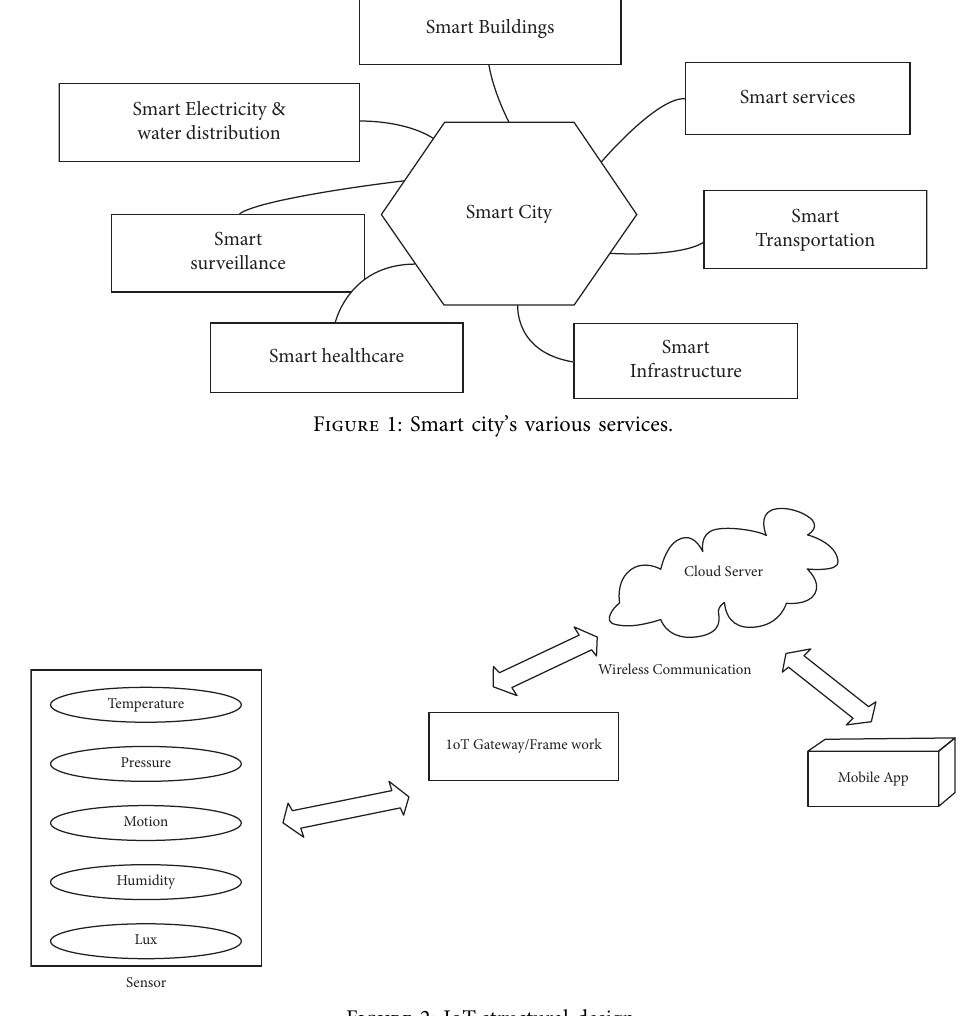
Figure 2: IoT structural design.